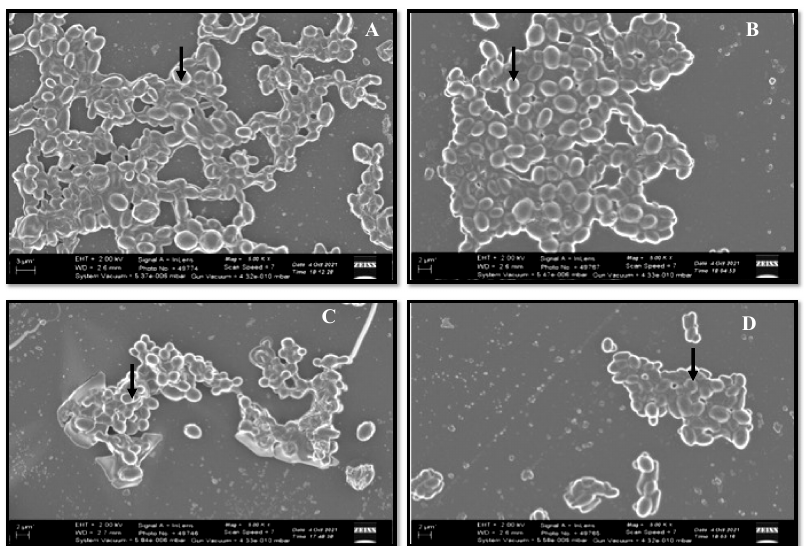
Figure 2. Representative SEM images of biofilms of different C. glabrata isolates. The cells were grown under biofilm-forming conditions, and the biofilm architecture was analyzed using SEM. ( A ) C. glabrata ATCC2950, ( B ) C. glabrata 3471, ( C ) C. glabrata 3469, ( D ) C. glabrata 3471. The arrows show C. glabrata cells embedded in the biofilm matrix.